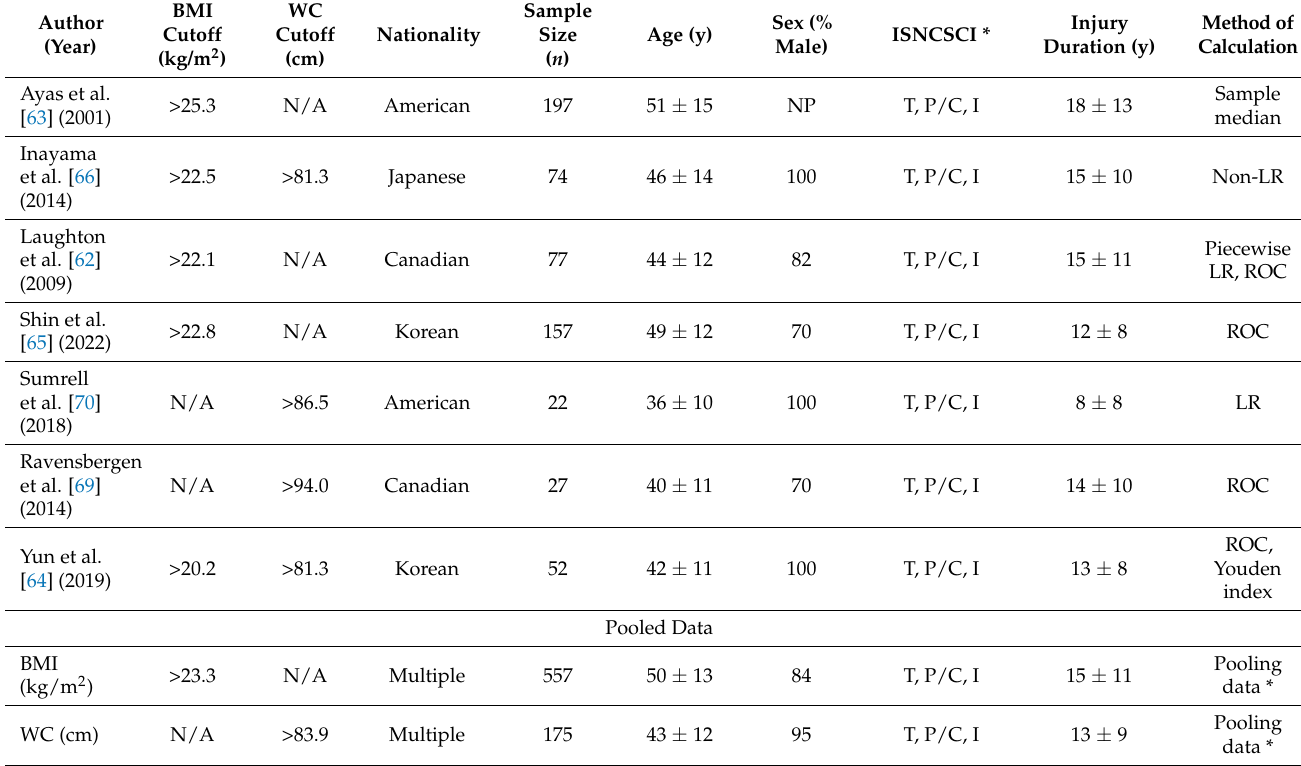
Table 3. Population-specific Body Mass Index (BMI) and Waist Circumference (WC) Thresholds in Spinal Cord